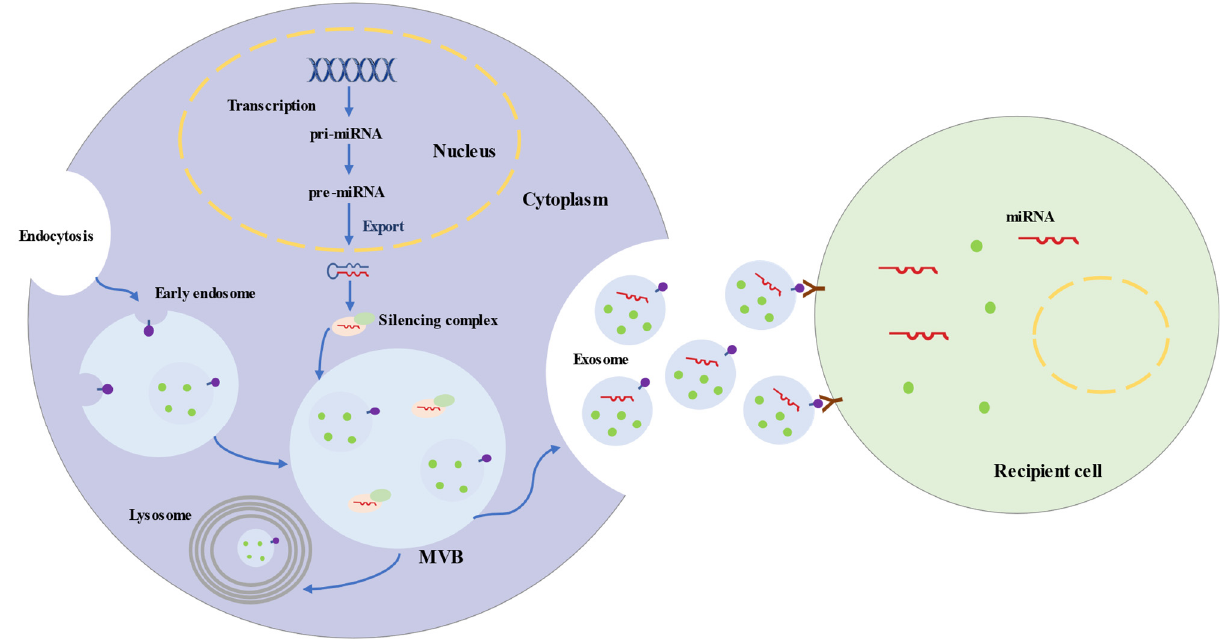
Figure 1. Biogenesis and Secretion Processes of Exosomes and Exosomal microRNAs. Exosomes are uniformed spheroids with a bilayered lipid membrane. The membrane is rich in cholesterol, sphingomyelin, ceramide, and surface markers from the parent cell, including tetraspanin proteins (CD63, CD81, and CD9), flotillin 1, Alix, and tumor suscep- tibility gene 101 protein [37,38]. Exosomes carry biologically active substances (proteins, lipids, DNAs, RNAs, and microRNAs), which can mediate cellular communication and antigen presentation, immune reaction, cell binding, and catalytic activity. In